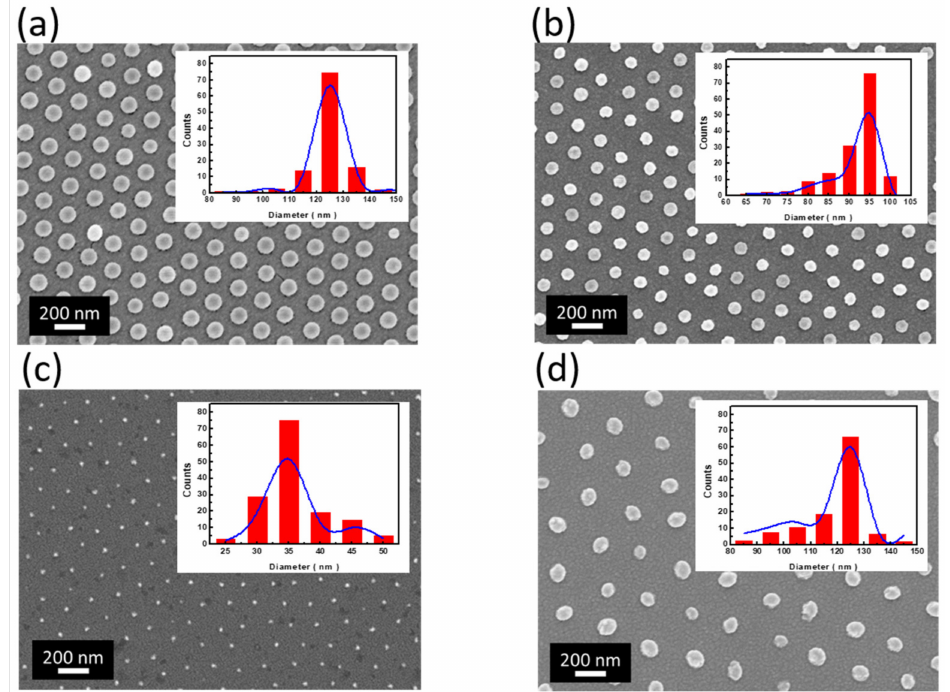
Figure 2. Top-view SEM images of self-assembly PS arrays after undergoing RIE treatment with ( a ) 25 s using 200-nm PSs, ( b ) 35 s using 200-nm PSs, ( c ) 45 s using 200-nm PSs, and ( d ) 45 s using 300-nm PSs. The Gaussian fit of pattern distributions in terms of their sizes was also presented indicating that the average particle sizes were 124.8 nm ( a ), 91.6 nm ( b ), 35.3 nm ( c ), and 125.1 nm ( d ),